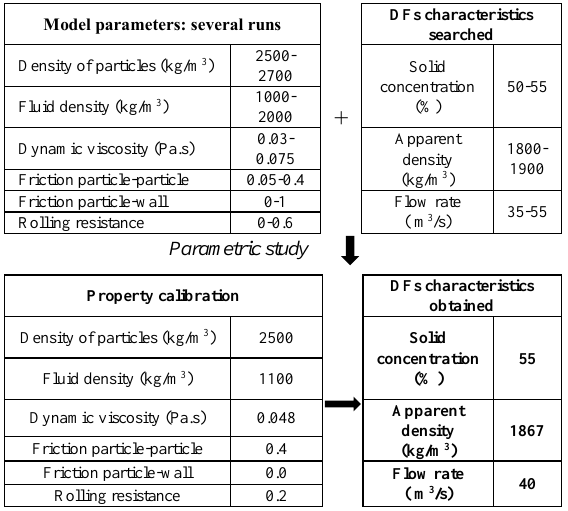
Fig. 3. Characteristics of the simulated